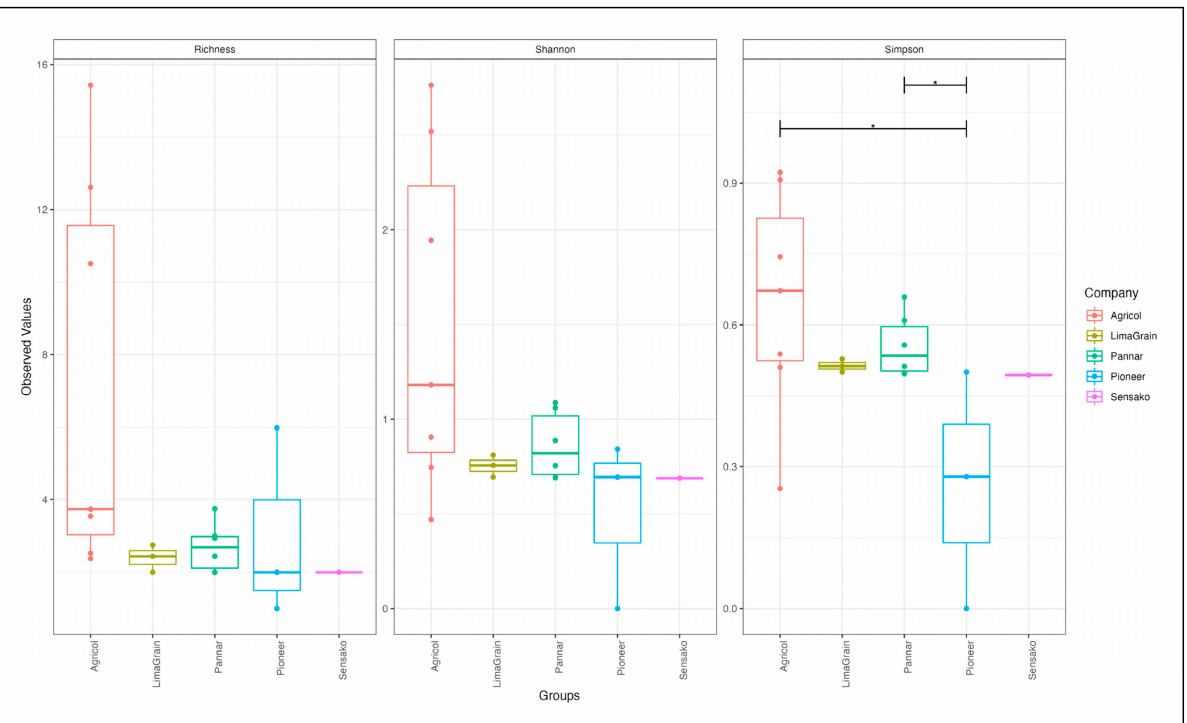
Figure 11. Bacteria alpha diversity measurement (observed number of ASVs (richness) for Chao1 ( left ), Shannon diversity ( middle ) and Simpson index ( right ) of sunflower seed